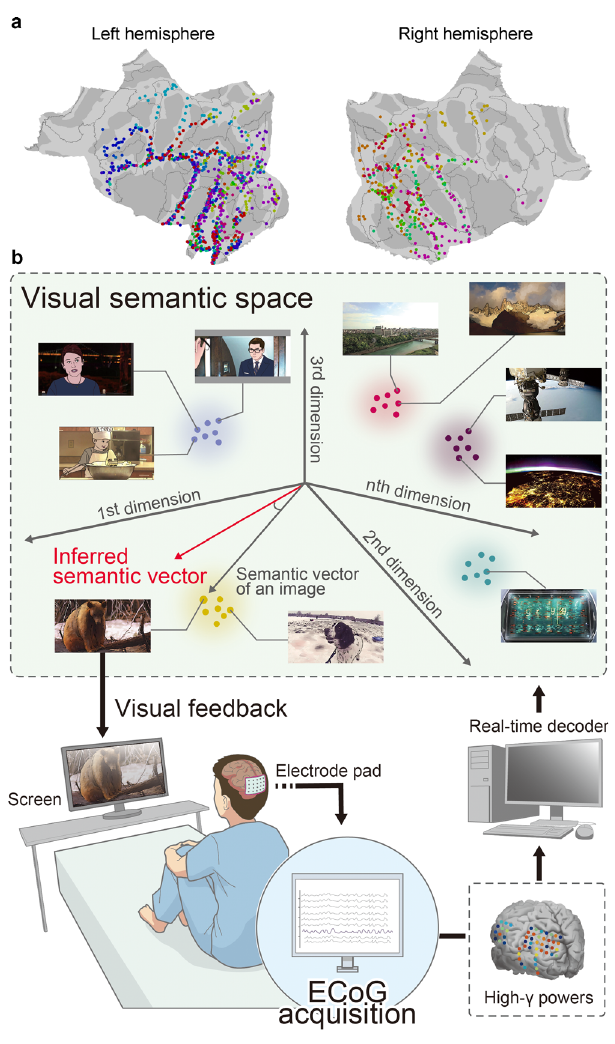
Fig. 1 Location of electrodes and schematic of a closed-loop system. a Locations of subdural electrodes are color-coded for each subject who participated in this study ( n = 21). b ECoGs were acquired in real time to infer a semantic vector of 1000 dimensions in the visual semantic space from power in the high- γ band. An image that had the nearest semantic vector to the inferred semantic vector was presented to the subject as a feedback image. Because of copyright restrictions, the actual images used in the tasks have been replaced with illustrations throughout this paper. Details of the creation of the illustrations are presented in “ Methods ”